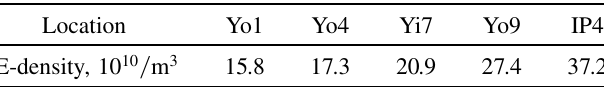
TABLE IV. Electron density of the fill 7935 in 4 Yellow straight sections and 1 interaction region section. These 5 sections contain about 90% of all electrons in the entire ring, which are responsible for the Yellow beam emittance